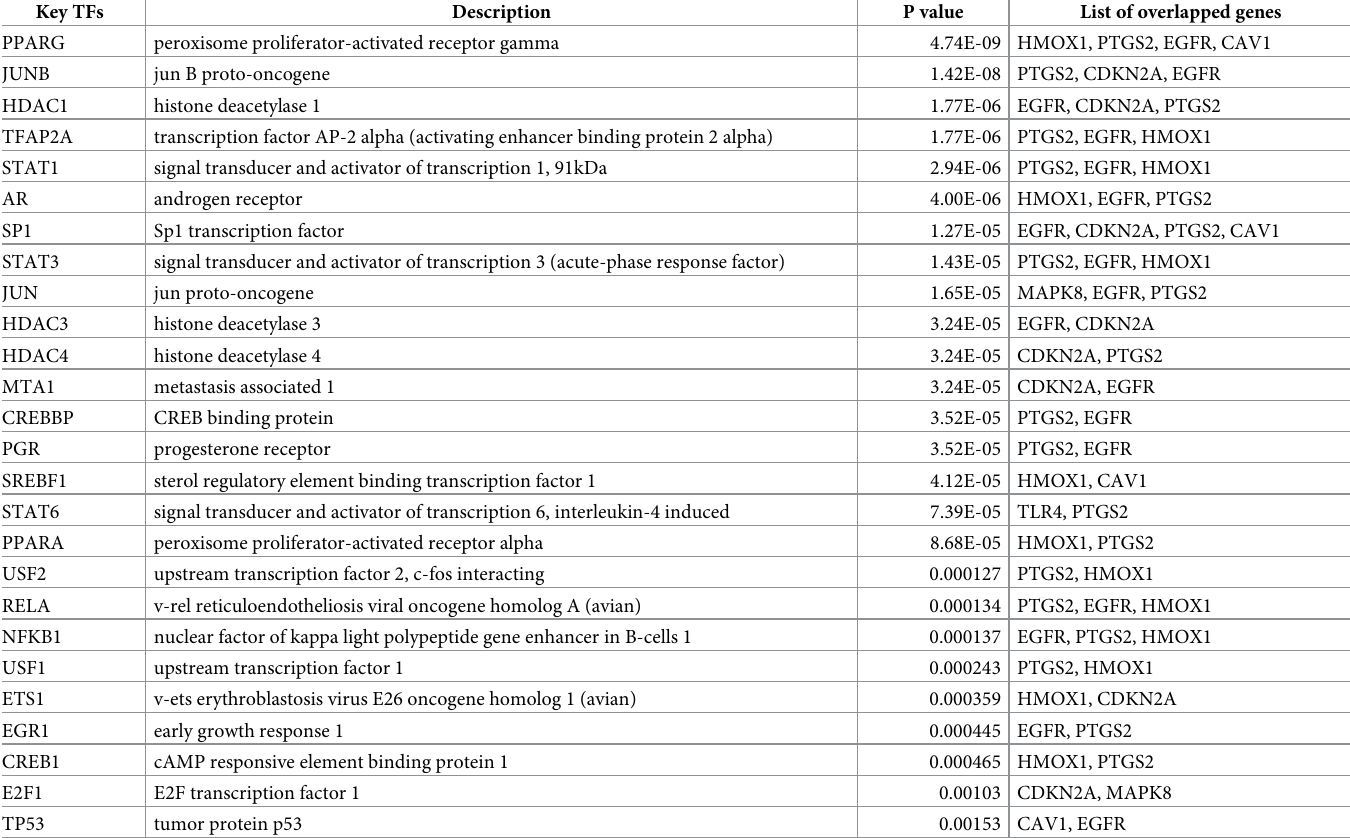
Table 4. Key TFs that regulate hub genes predicted by TRRUST database.